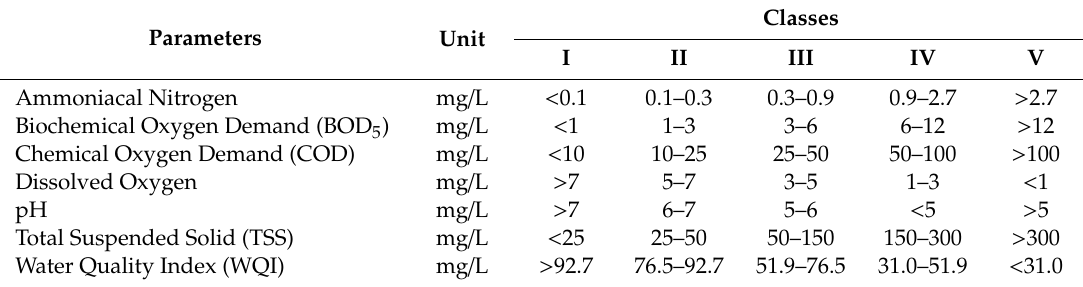
Table 4. Department of Environment (DOE) Water Quality Index classification.